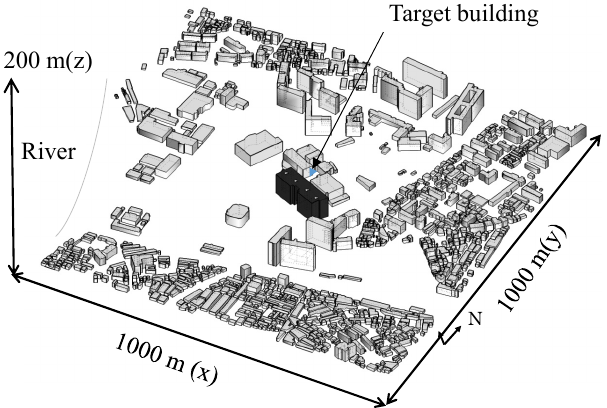
Figure 4. Geometry of the building configurations for computational fluid dynamics (CFD) simulations.